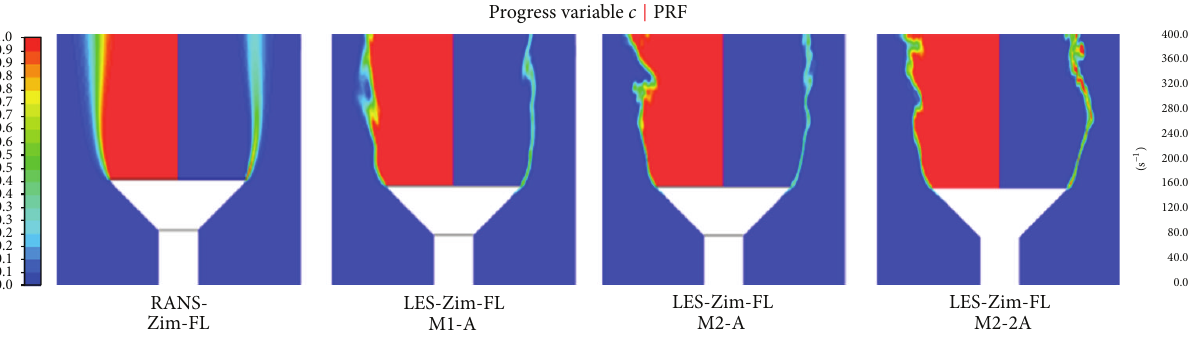
Figure 8: Instantaneous progress variable and PRF (bluff body